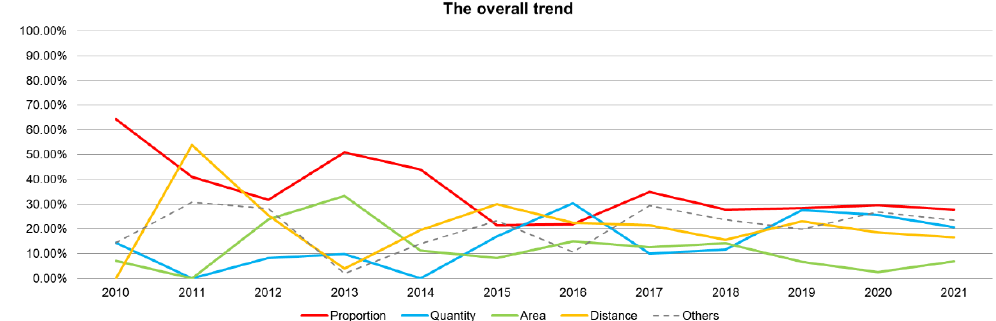
Figure 11. The annual distribution of the proportion of index categories.